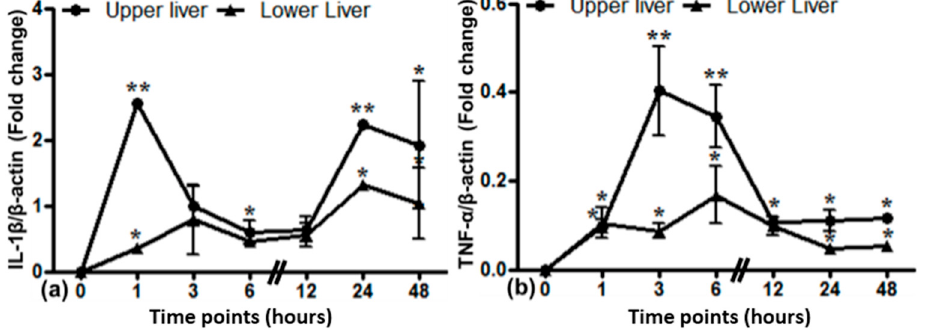
Figure 9. Relative mRNA expression of acute phase cytokines IL-1 β ( a ) and TNF- α ( b ) in the upper and lower liver from the irradiated lung experiment. The results were normalized to β -actin as the housekeeping gene. Experimental errors are depicted as ±SEM (* p ≤ 0.05, ** p ≤ 0.005, n = 3).